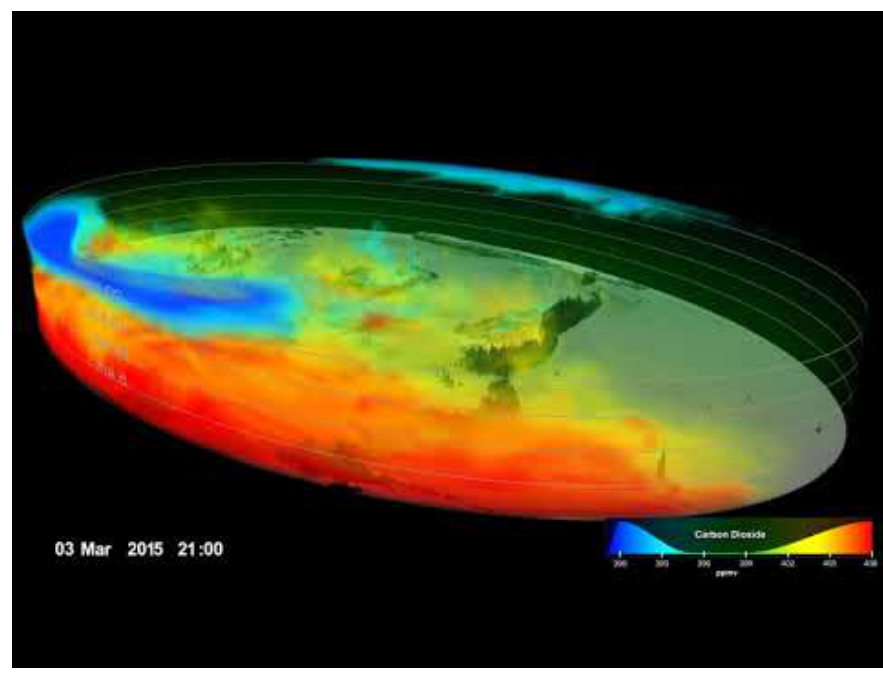
Figure 2: Clip from climate visualization Carbon Dioxide from GMAO Using Assimilated OCO-2 Data (2016) showing turbulence, especially in the top half of the image. Source: Clip made by author from original by NASA Scientific Visualization Studio. Available at https://svs.gsfc.nasa.gov/4514. URL: